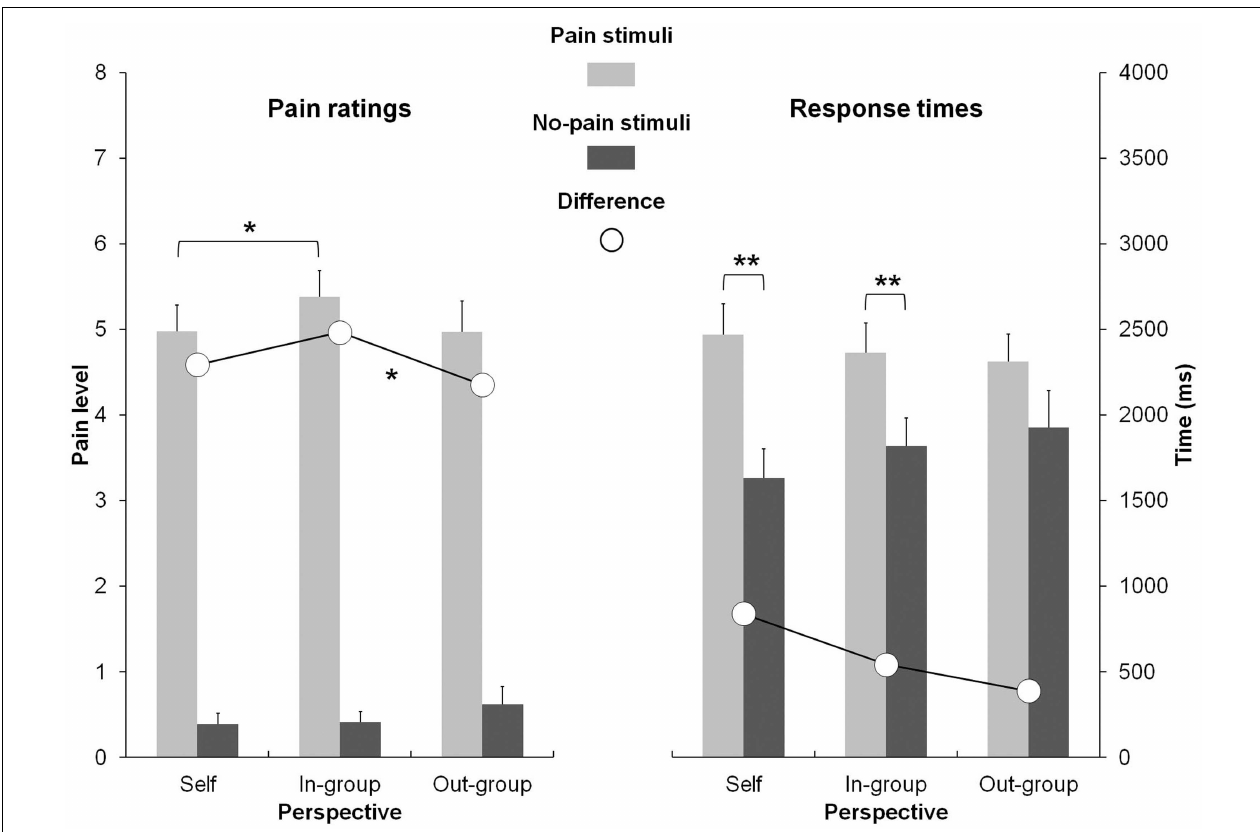
FIGURE 1 | Pain ratings (left) and response times (right) as a function of stimuli (pain vs. no-pain) and perspective (self vs. ingroup vs. outgroup). * < 0.05; ** < 0.001.